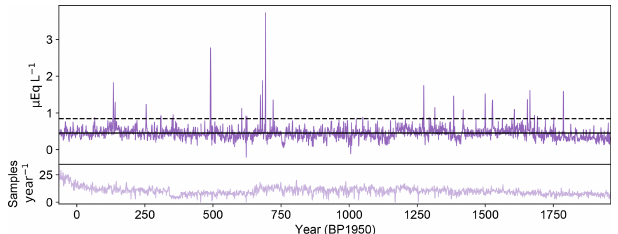
Figure 14. Time series for annually averaged non-sea-salt sulfate. Solid black line indicates the 2000-year mean value. Dashed black line indicates 2 σ value.